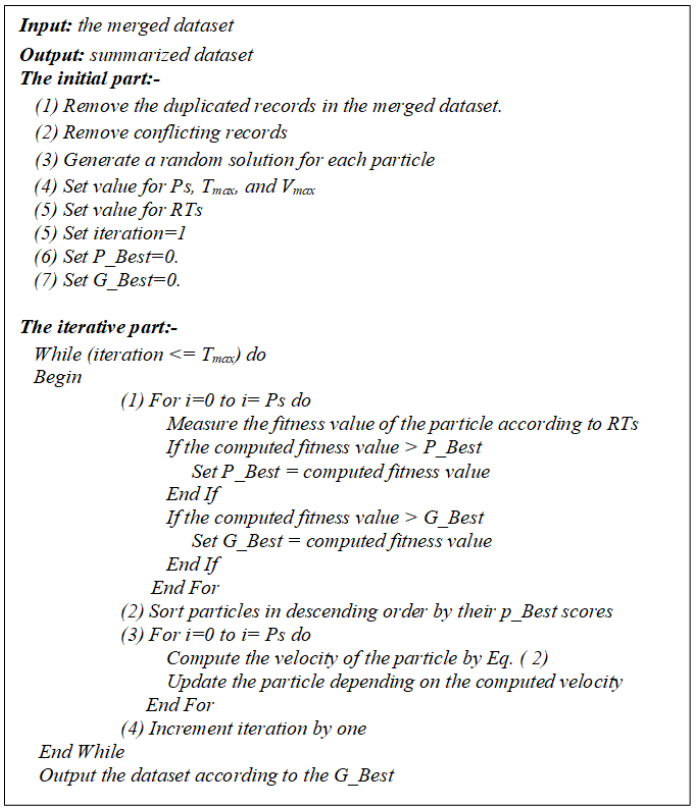
Figure 3. Proposed PSO algorithm for dataset